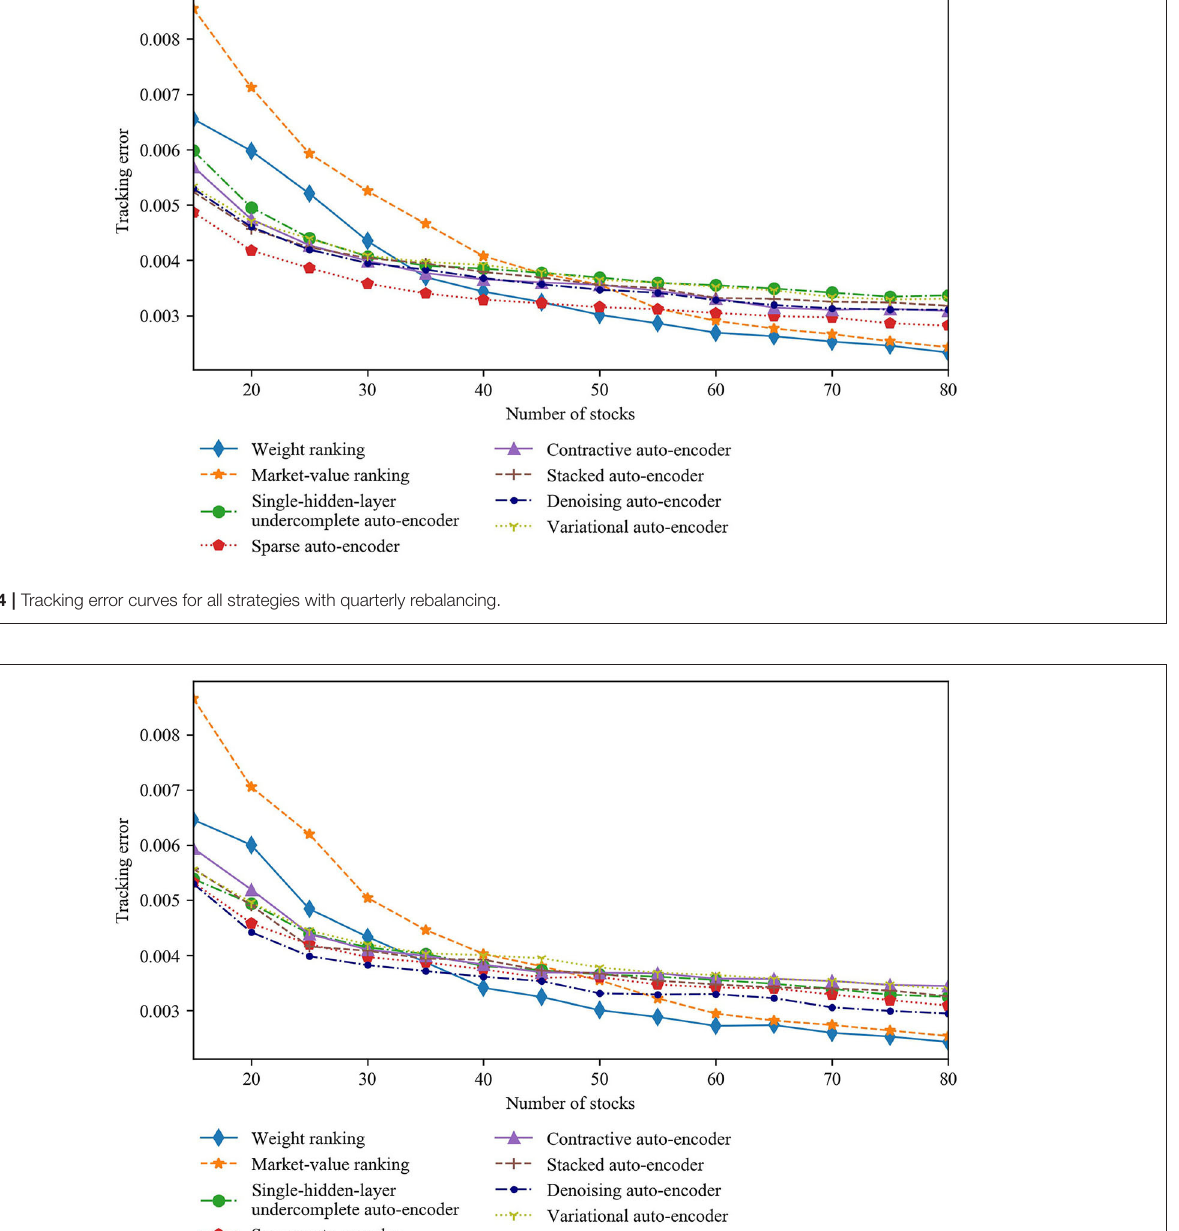
year training sets. In addition, the tracking error values change little in response to variations in the length of the training